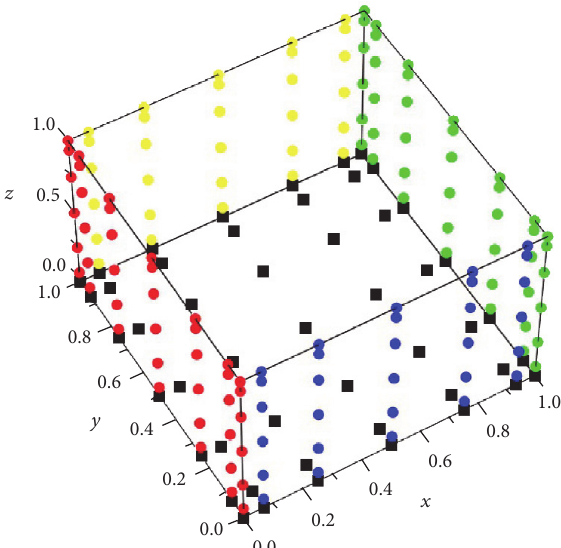
Figure 4: CGL collocation points in the unit cube for 𝑁 = 6 for 2D wave